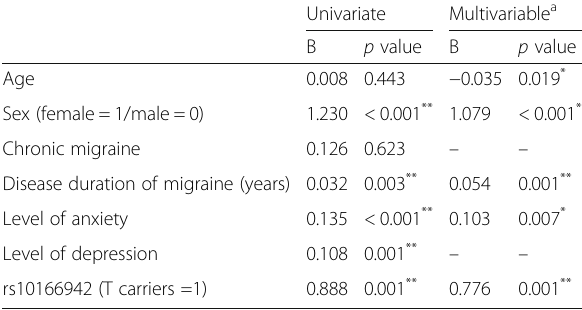
Table 4 Demonstration of the associations between allodynia severity and rs10166942 genotypes by general linear models